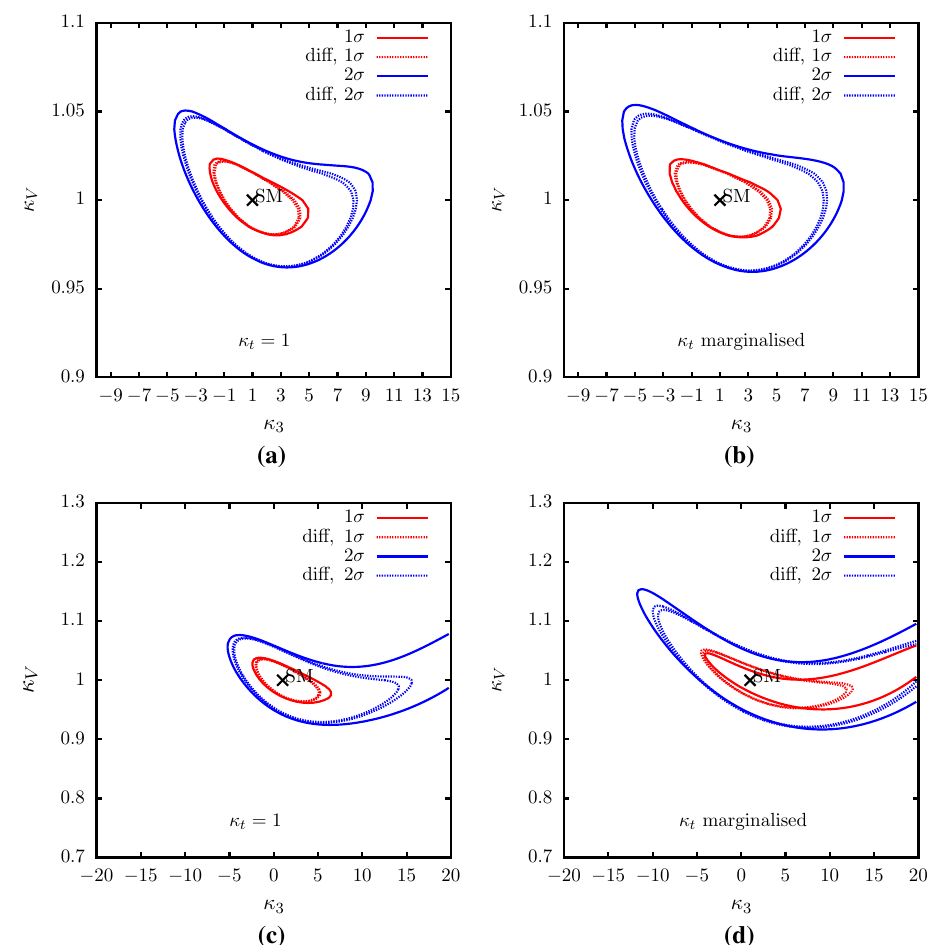
Fig. 15 Bounds on κ V and κ 3 . Left: κ t = 1. Right: κ t marginalized. Upper: all channels considered in the fit. Lower: Only V H and t ¯ tH considered in the